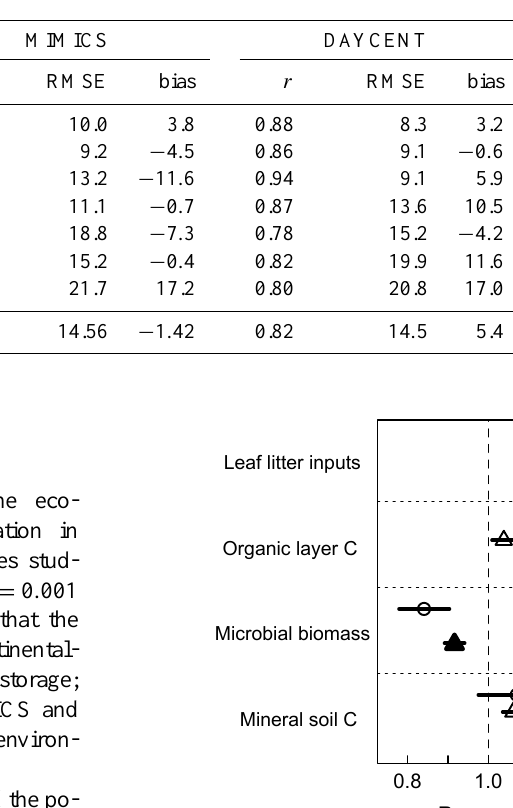
Table 1. Biome-aggregated results for leaf litter decomposition experiment that compares simulations from MIMICS and DAYCENT with observations from the LIDET study (Fig. 2). Models were sampled at the same time as observations for each litter type decomposed at each site. Data show the number of observations ( n ), Pearson’s correlation coefficient ( r ), root mean square error (RMSE), and bias calculated between observed and simulated percent mass remaining. Sites grouped into each biome include tundra (ARC and NWT); boreal forest (BNZ); conifer forest (AND); deciduous forests (CWT, HBR and HFR); humid grasslands (CDR, KBS, and KNZ); arid grasslands (JRN, SEV, SGS); and tropical forest (LUQ; Table B1 for site abbreviations).